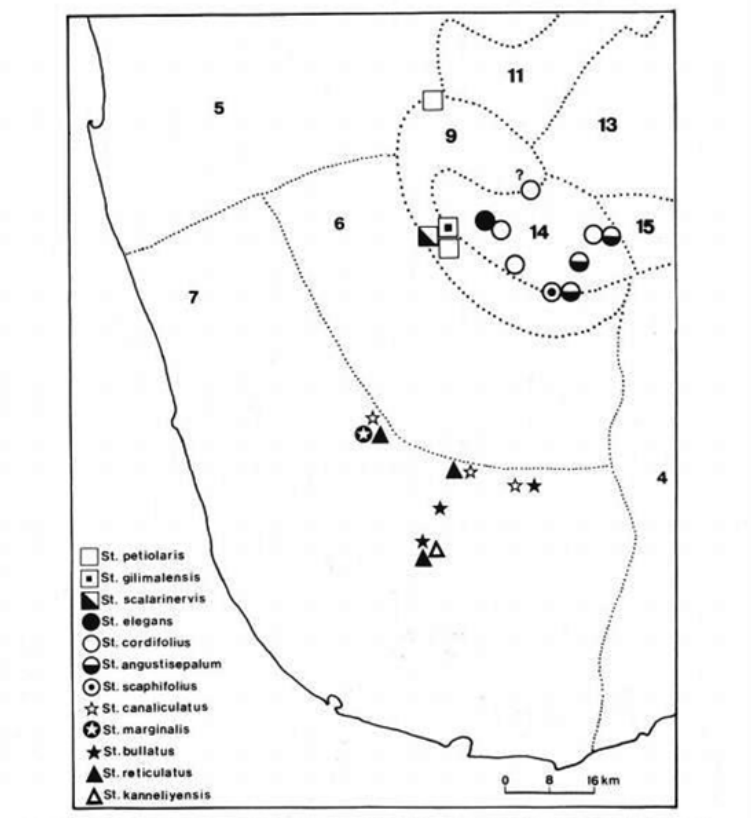
Figure 4 : Restricted distribution of species of Stemonporus (Dipterocarpaceae) in SW Sri Lankan floristic regions (From Ashton and Gunatilleke,